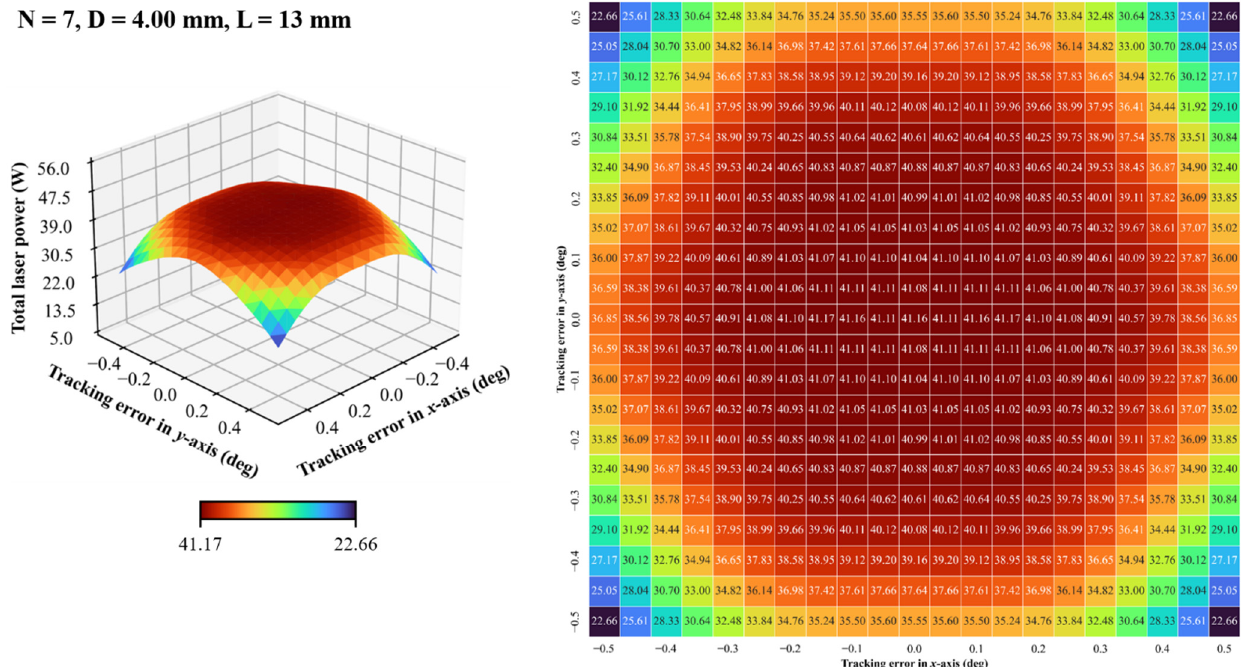
Figure 10. Total solar laser power in multimode regime as a function of the solar tracking error for the seven 4.00 mm diameter, 13 mm length rods scheme.